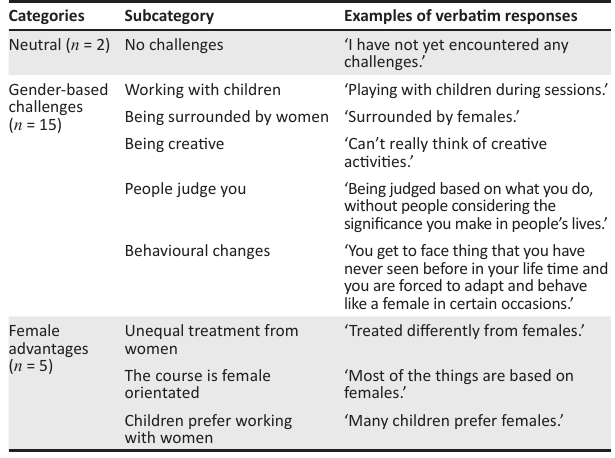
TABLE 6: Challenges of being male in a female-orientated training programme ( n = 22).